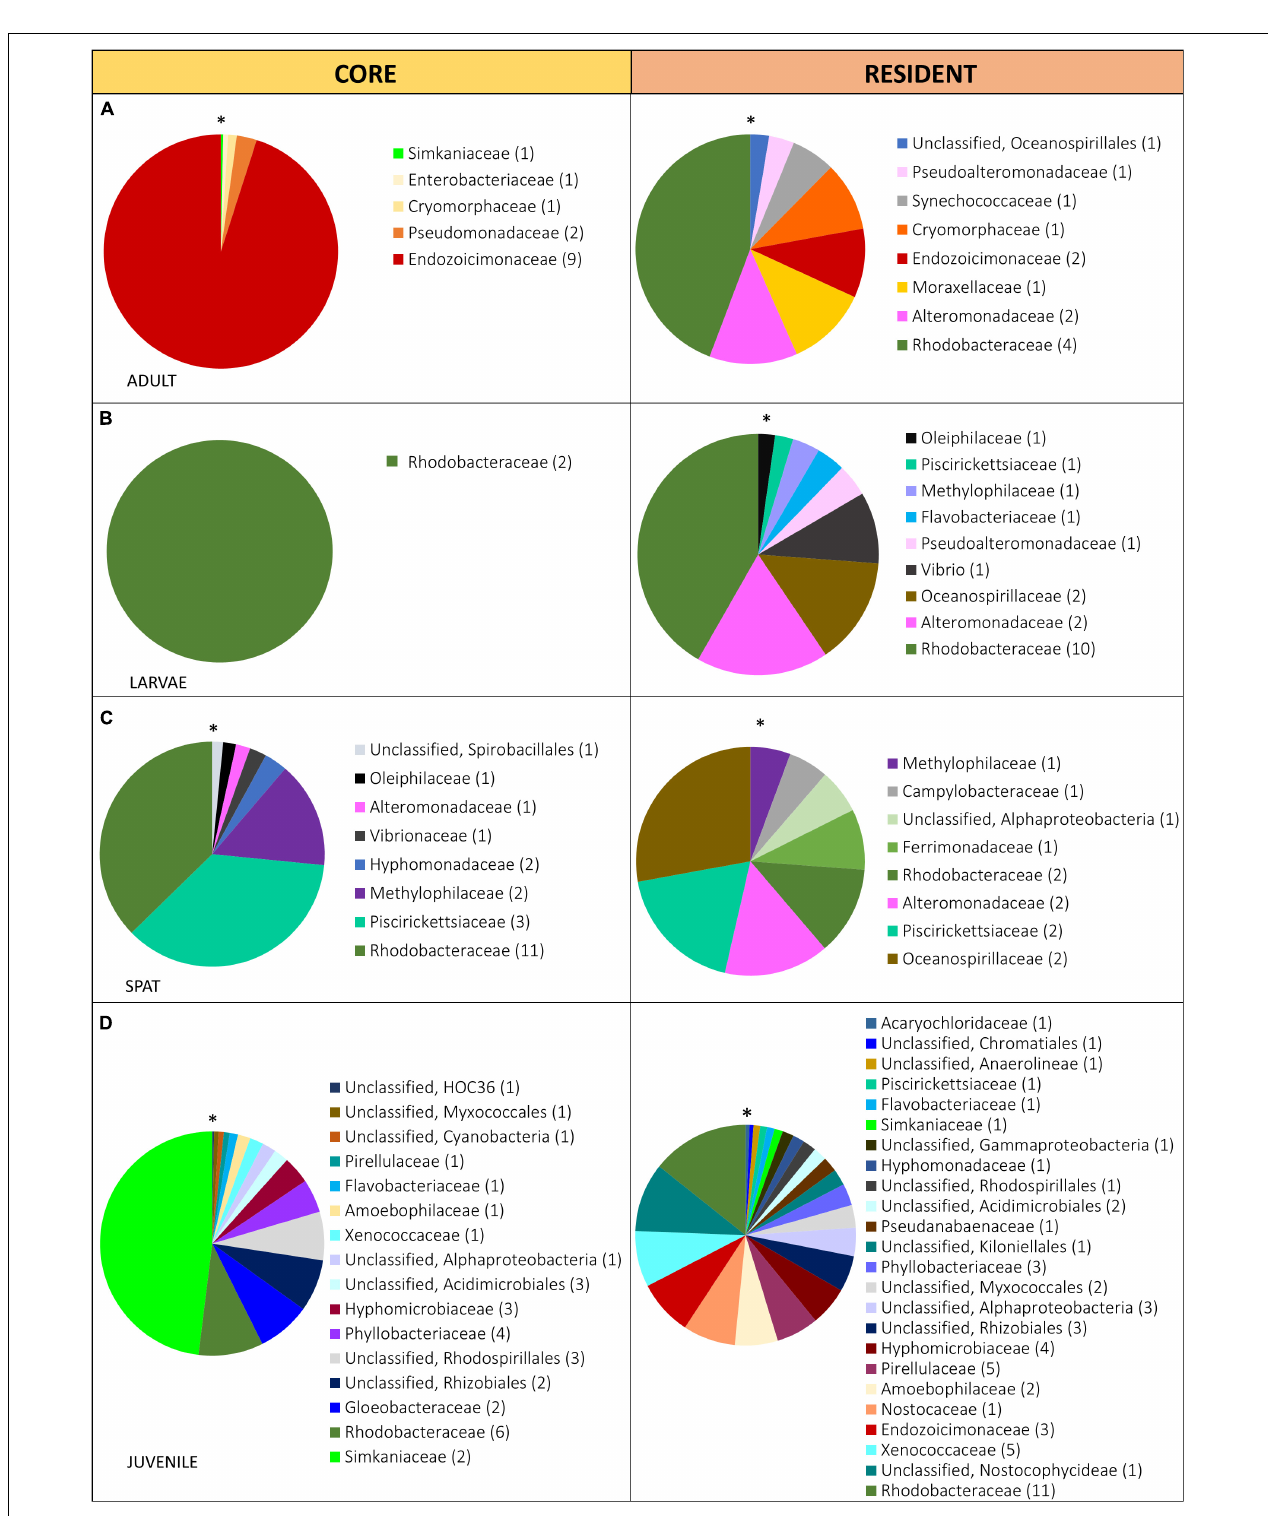
FIGURE 3 | Relative abundance of the bacterial taxa within the core (present in 80% of the samples) and the resident (present in 50% of the samples) microbiome in: (A) Adult, adult colonies, (B) Larvae, 2- and 4-day-old larvae; (C) Spat, newly settled spat; and (D) Juvenile, 6-month-old juveniles. Sequences were classified at family level where possible, with unclassified species indicated at higher taxonomic resolution. Families within each pie chart are organized from the lowest (*) to the highest abundance (clockwise direction).